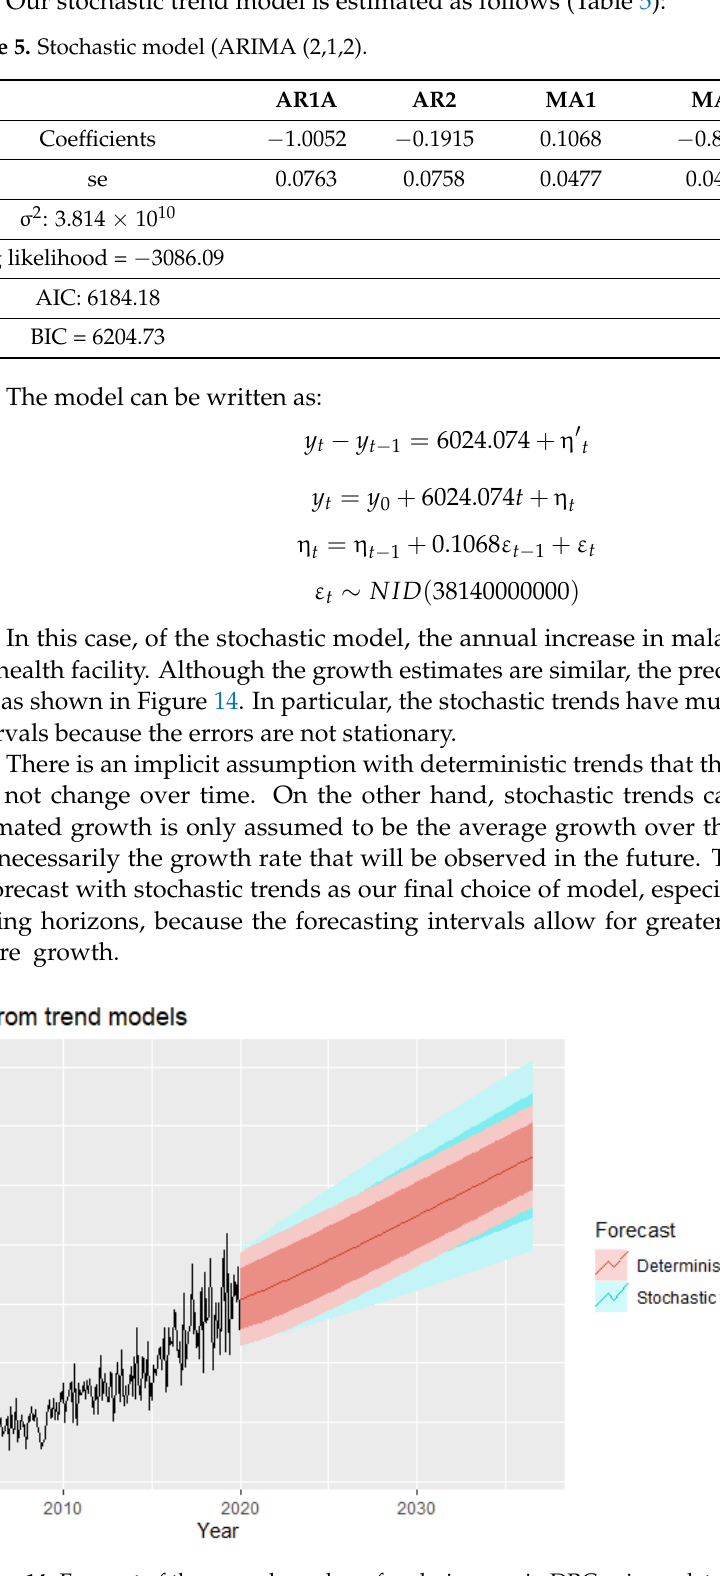
Figure 14. Forecast of the annual number of malaria cases in DRC using a deterministic trend model and a stochastic trend model. and a stochastic trend